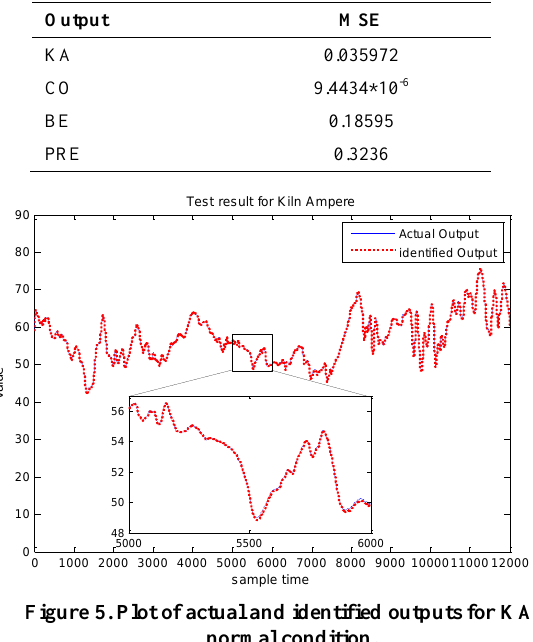
Table 4. MSE of model for test data in normal condition